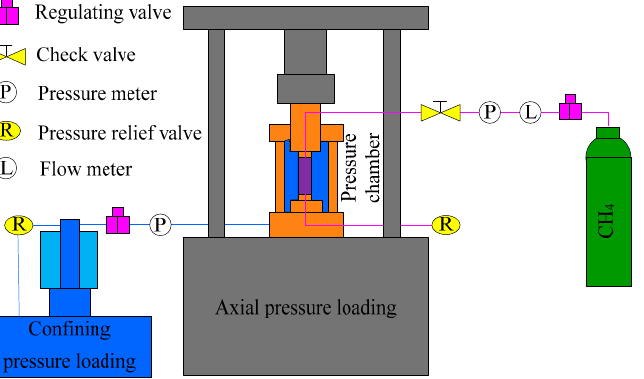
Figure 3. Schematic diagram of the principle of the permeability determination test.